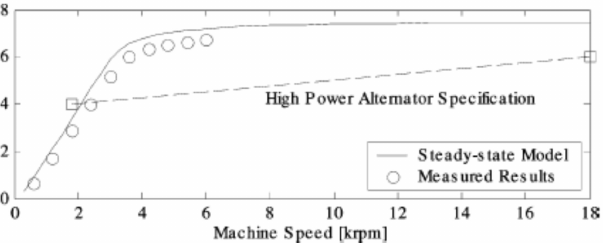
Figure 33. Output power for PM alternator with switched-mode regulator (SMR) “Adapted with permission from [32]”.